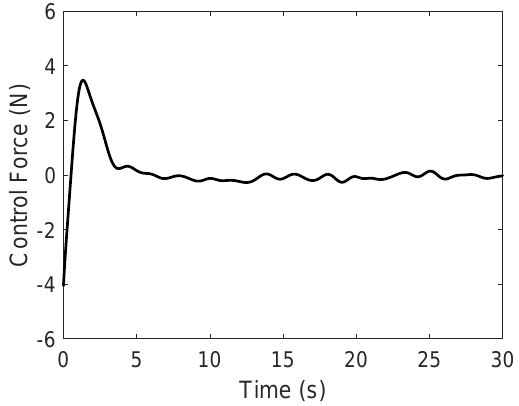
Figure 3. Optimal feedforward